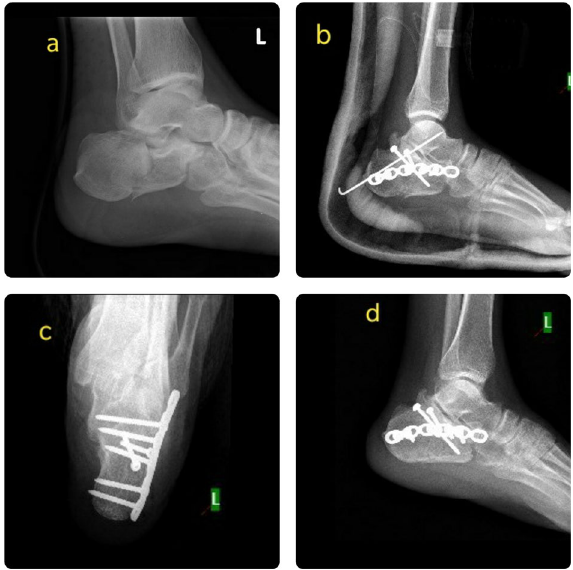
Figure 2. Calcaneal fracture treated by operative method. ( a ) Preoperative radiograph, ( b ) post-operative radiograph, ( c , d ) radiographs at one year follow up.